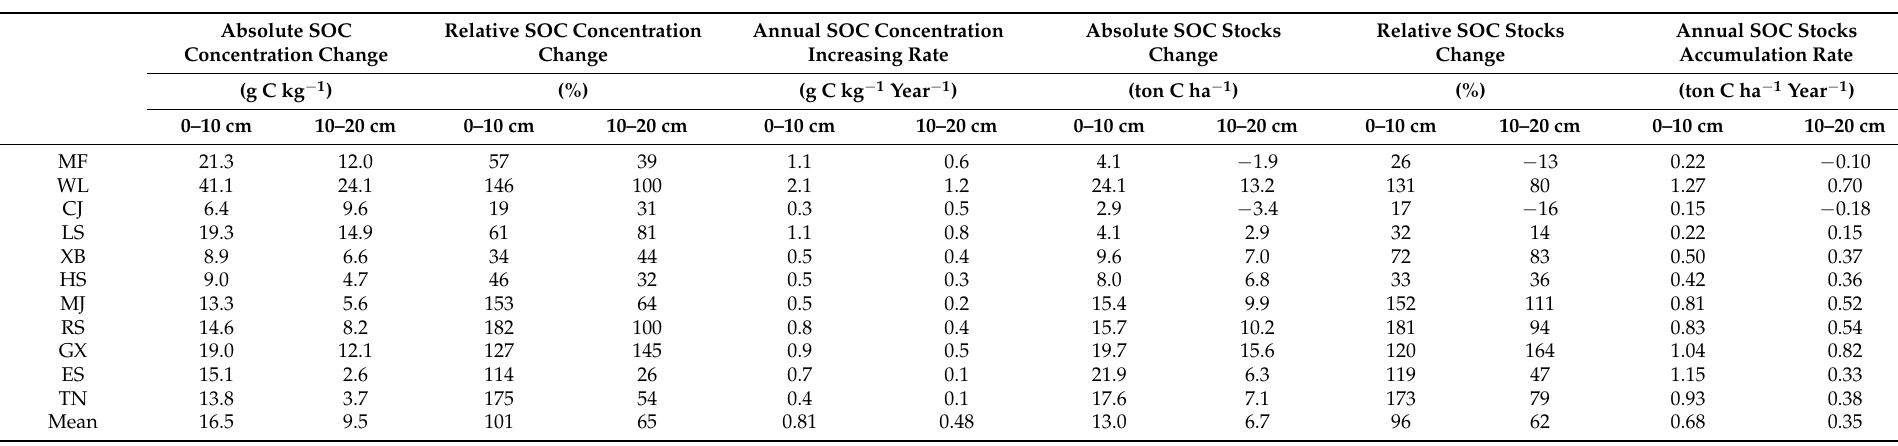
Table 3. Absolute change, relative change, and annual accumulation rate of soil organic carbon (SOC) concentrations and stocks after forest regeneration of agricultural fields in